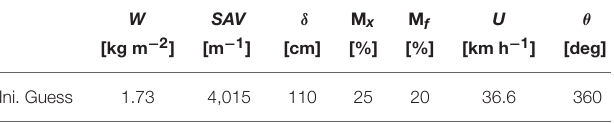
TABLE 1 | Values of the parameters estimated to initialize the assimilation run.